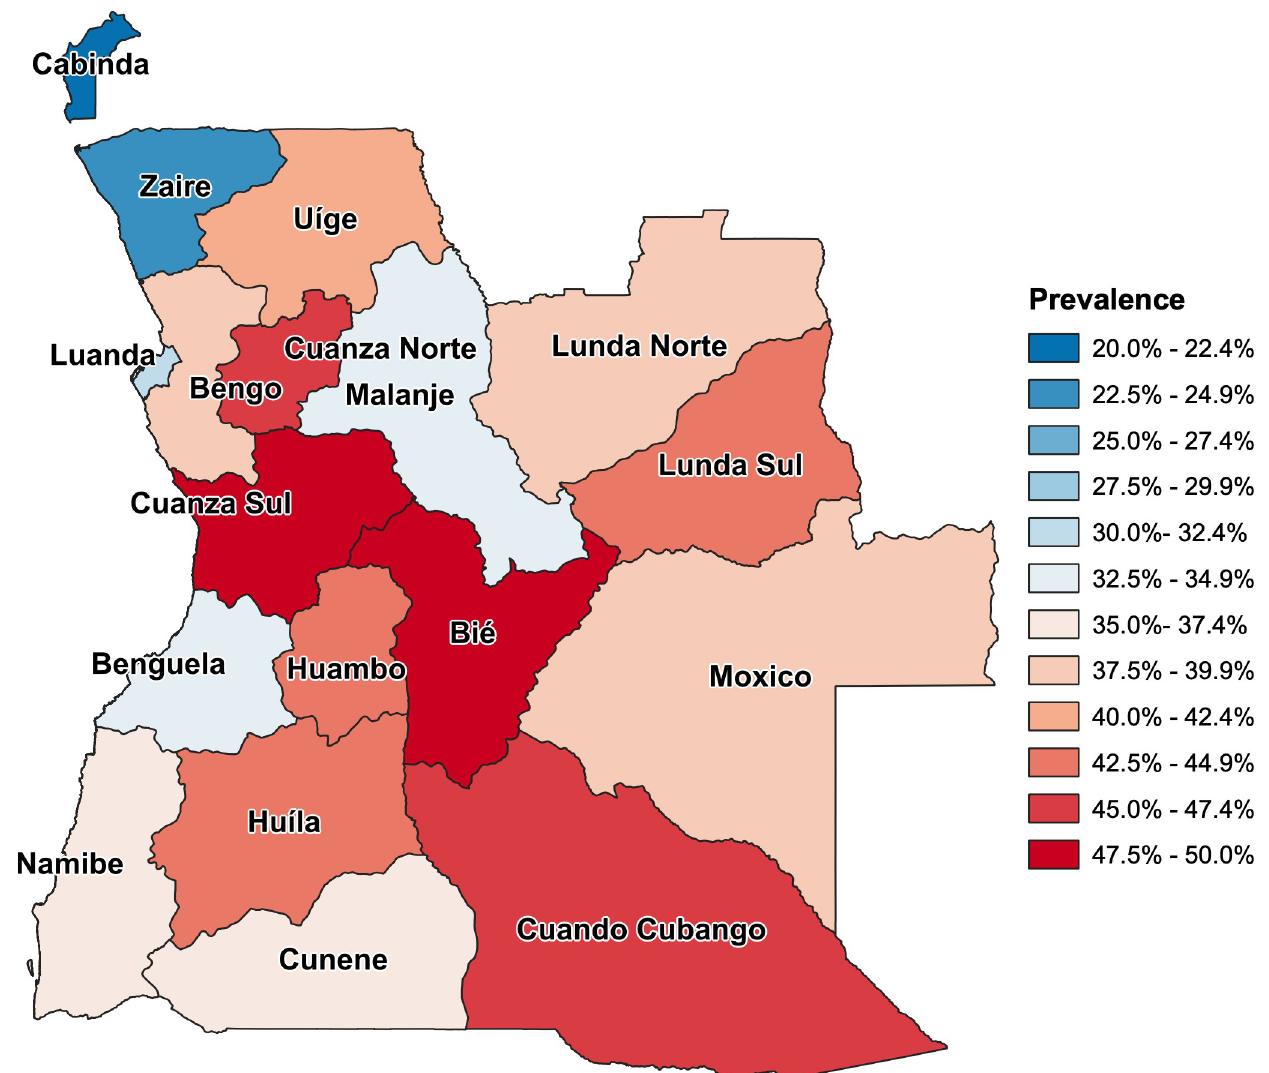
Fig 2. Map of the Republic of Angola displaying prevalence of stunting by province. Map shows the territory of the Republic of Angola with the 18 provinces color-coded according to prevalence of stunting among children 0 to 59 months of age estimated in the Angola 2015–2016 DHS (Table 1). Base layer map shapefile was obtained from GADM (https://gadm.org/maps/AGO.html) [40]. Terms and conditions of use available from https://gadm.org/